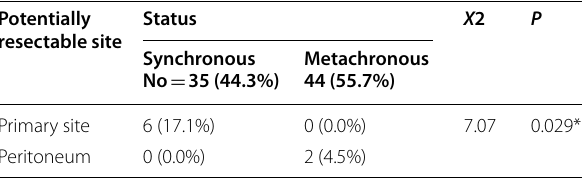
Table 5 Patients with partial response and remaining